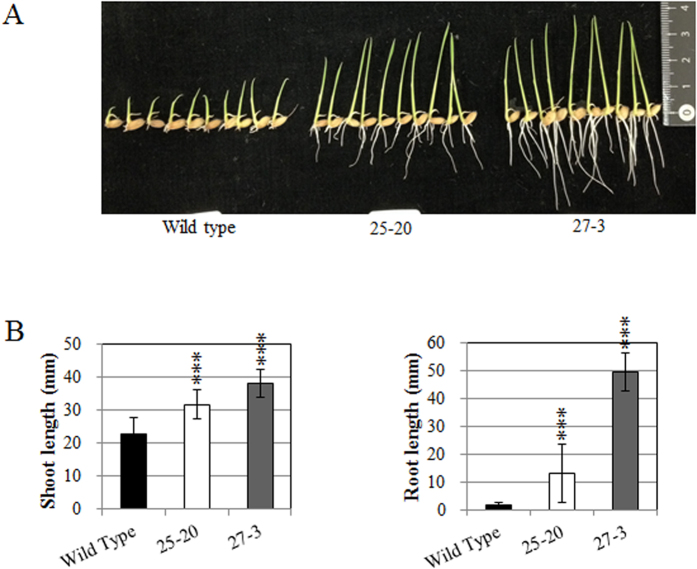
Growth of transgenic rice seedlings overexpressing OsABA8ox1 and wild-type seedlings (control) at cold temperatures.(A) Typical seedlings of Toyohikari (wild type) and transgenic lines overexpressing OsABA8ox1 at 15 °C. (B) Shoot and root length of seedlings grown at 15 °C for 15 days. Values are means ± SD of 27 biological replicates. Significant differences between transgenic and wild-type seedlings were determined by Student’s t-tests. *** represent P < 0.001.